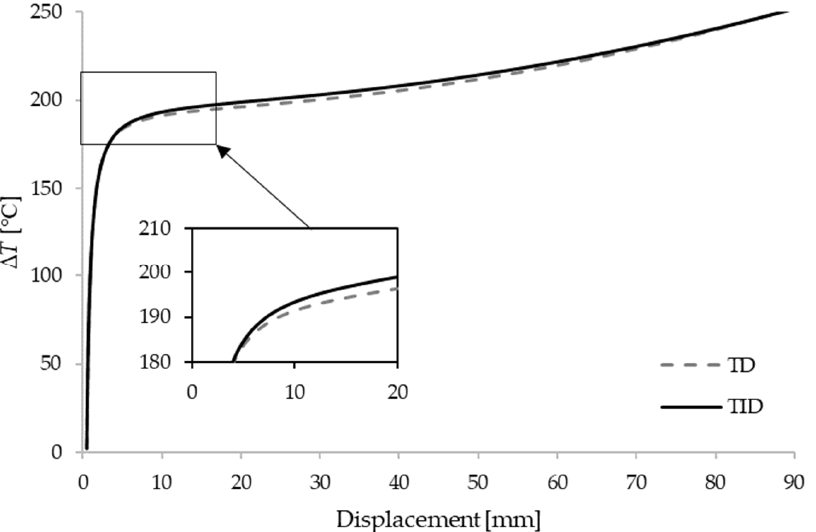
Figure 6. Critical temperatures vs. displacement for a clamped–clamped beam L 1 = 6 m with λ = 0.8.